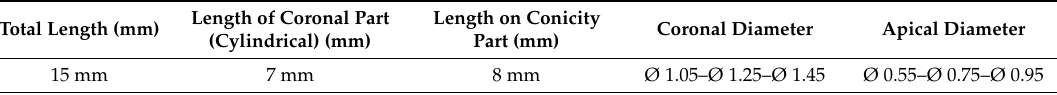
Table 1. Geometrical characteristics of the posts: length of coronal part, length of conicity part, coronal diameters, and apical